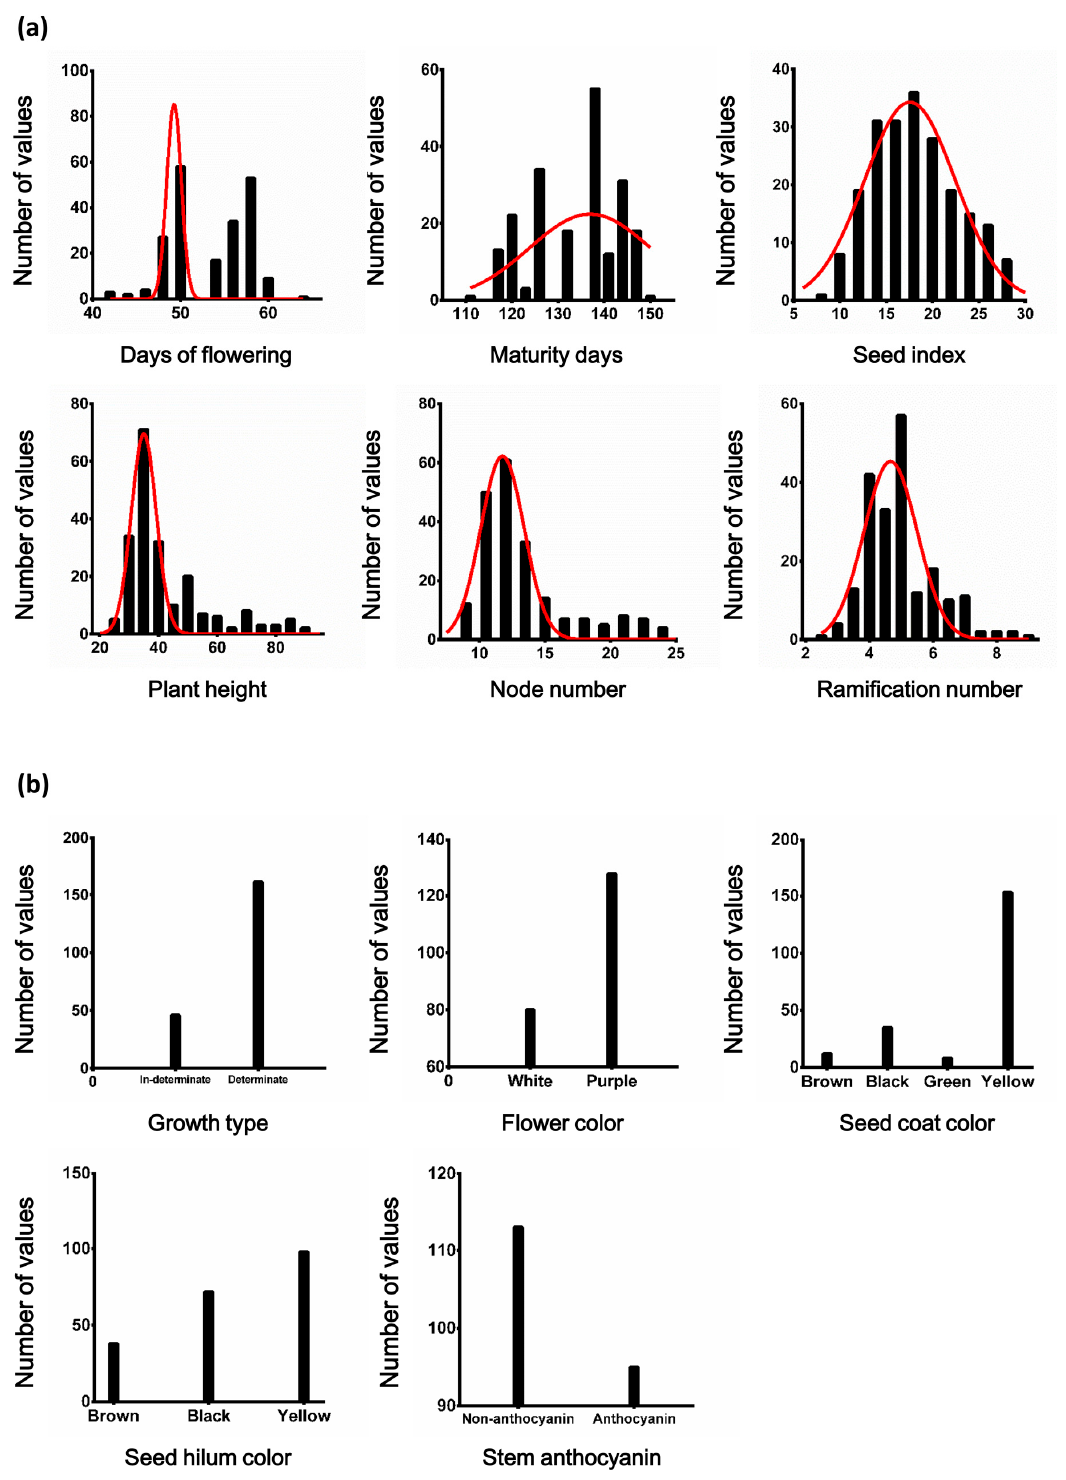
Figure 2. Distribution of agronomic traits among 208 soybean MDP lines. Data are presented for ( a ) six quantitative traits (DF, MD, SI, PH, NN, and RN) with gaussian fitting curve and ( b ) five qualitative traits (GT, FC, SCC, SHC, and SA).